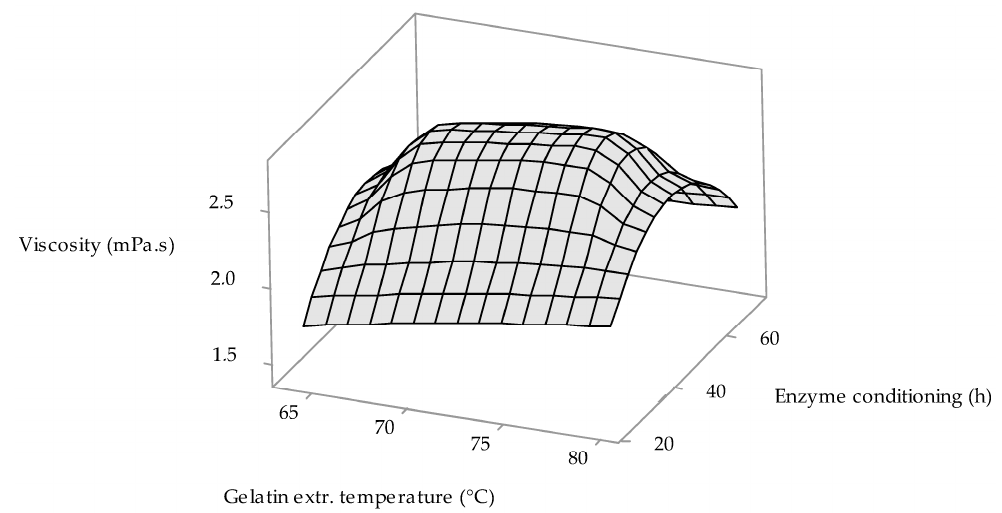
Figure 3. The influence of the gelatin extraction temperature and enzyme conditioning time on the gelatin viscosity.